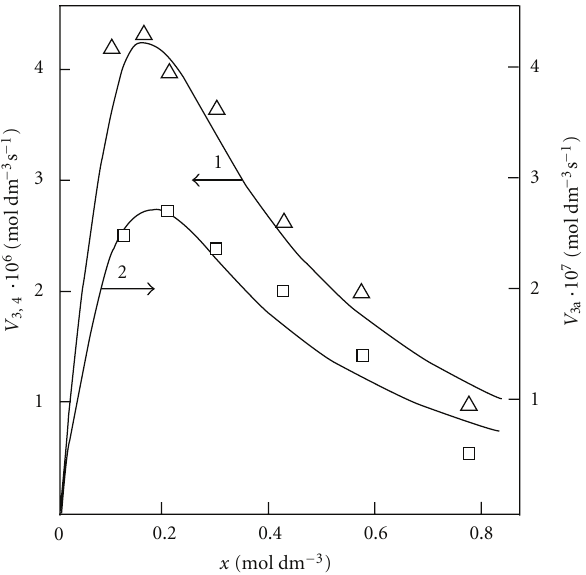
Figure 2: Reconstruction of the functional dependence (curves) of the product formation rates V 3, 4 and V 3a on the initial concentra- tion x of free formaldehyde (model optimization with respect to the parameters α , β and k 2 ) from empirical data (symbols) for the 1- propanol-formaldehyde system at 413 K [8, 9, 40]: (1) calculation (5), standard deviation of S Y = 2 . 20 × 10 − 7 ; (2) calculation using (6), S Y = 2 . 38 × 10 − 8